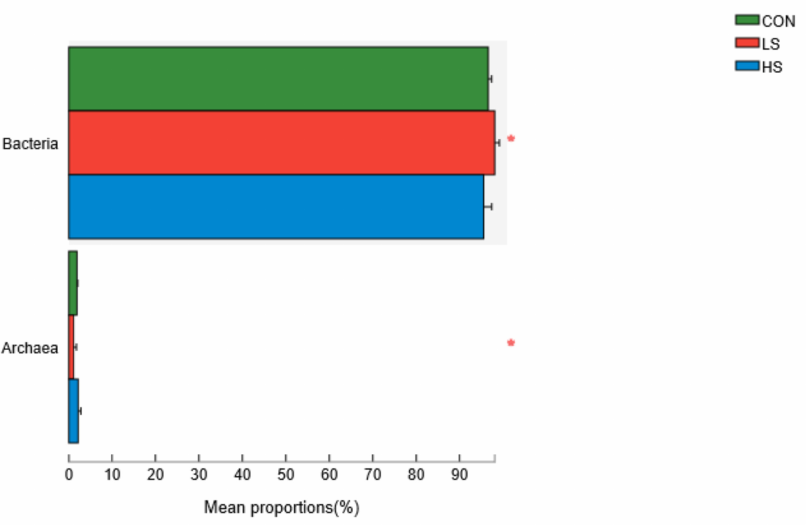
Figure 1. Differently rumen microbial domains among the three groups. CON = basal diet; LS = basal diet + 2.4 mg/kg SY; HS = basal diet + 4.8 mg/kg SY. * p < 0.05.